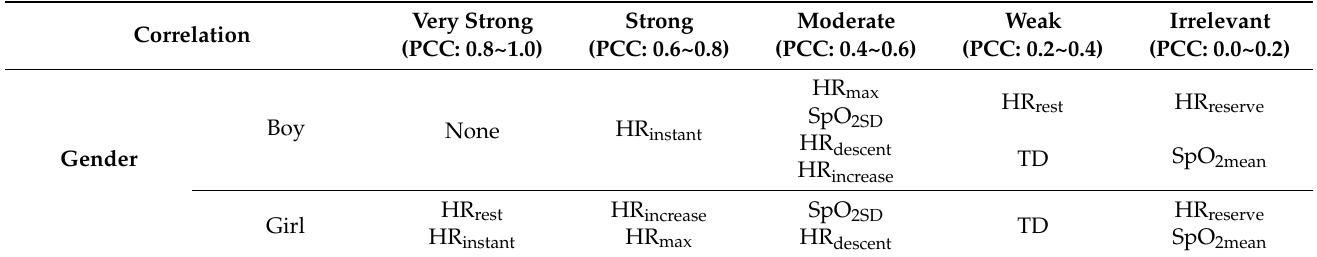
Table 4. Features distributed by degrees of correlation to physical fitness